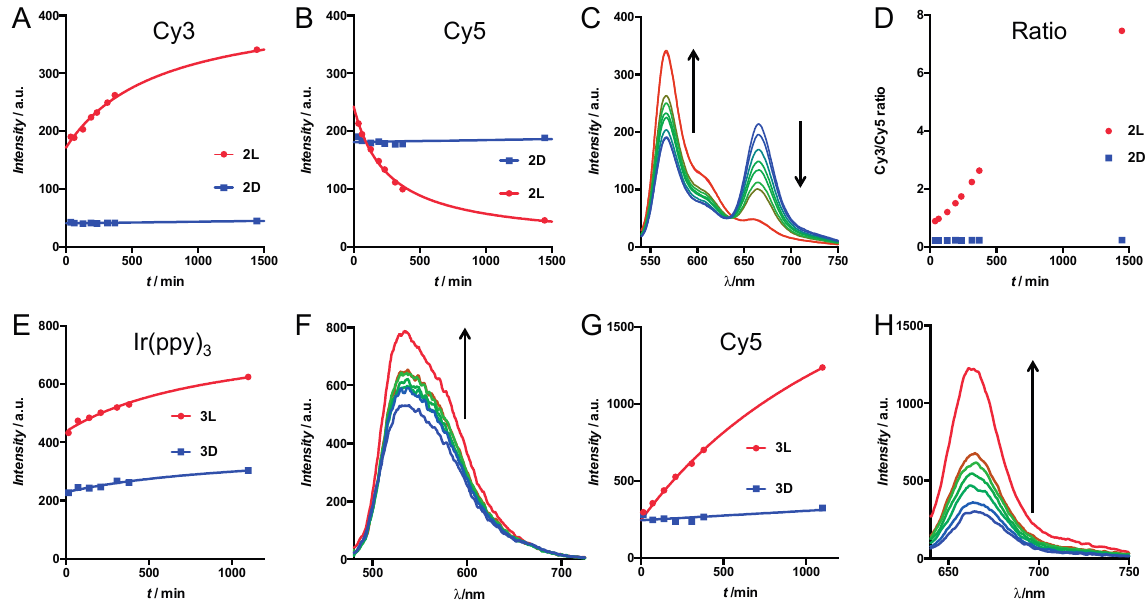
Figure 3. ( A – D ) Cleavage assay of 2L and 2D by MMP-expressing cells ( A , B ) Emission intensity from peptides 2L (red circles) and 2D (blue squares) of the donor peak (Cy3, excitation 525 nm, emission 566 nm) ( A ) and the FRET peak (Cy5, excitation 525 nm, emission 666 nm) ( B ) in time; ( C ) Variations in emission spectra (excitation 525 nm) of 2L in time from blue (first time point) to red (last time point) and ( D ) the donor/acceptor ratio; ( E – H ) Cleavage assay of 3L and 3D by MMP-expressing cells; ( E , G ) Emission intensity changes from peptides 3L (red circles) and 3D (blue squares) of the peaks at 590 nm ( E ) and 666 nm ( G ) in time; ( F , H ) Change in emission of these peaks of 3L in time from blue (first time point) to red (last time point) with excitation at 420 nm ( F ) or 625 nm ( H ). Arrows indicate change in